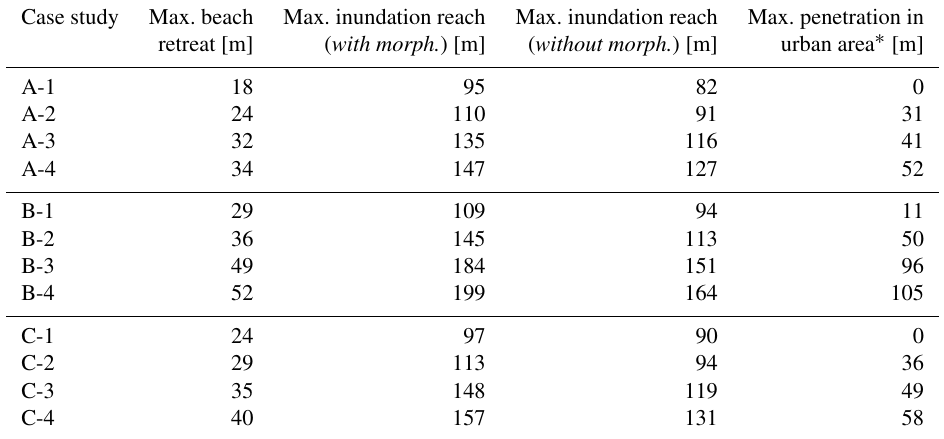
Table 6. Maximum coastline retreats, maximum flood reach (with and without morphodynamics) and maximum penetration into urban area calculated by XBeach for the case